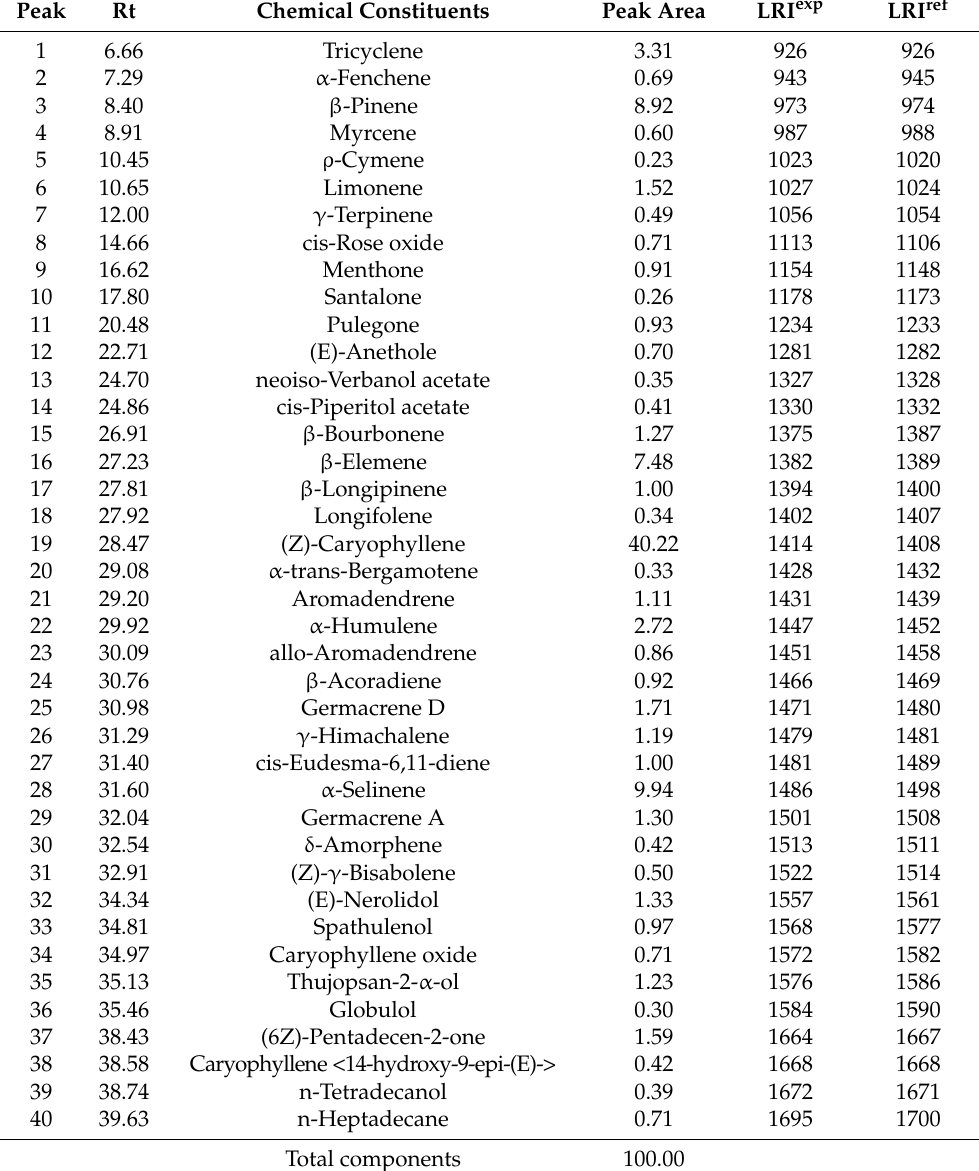
Table 1. Phytochemical constituents of the essential oil of A. muricata leaves determined by GC-MS.